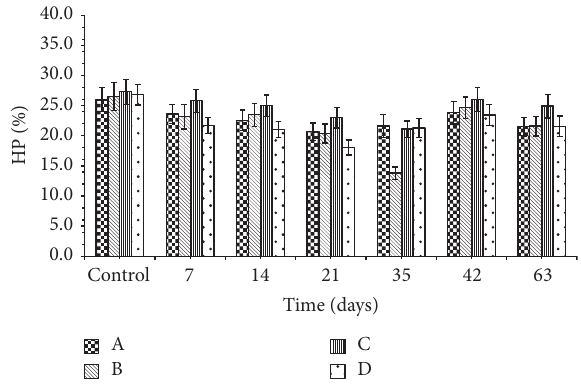
peroxyacetic acid at 25 ∘ C and 30 ∘ C versus time ( 𝜃 ). Figure 6: Evolution of hydrogen peroxide (HP) in the biocide samples during stability